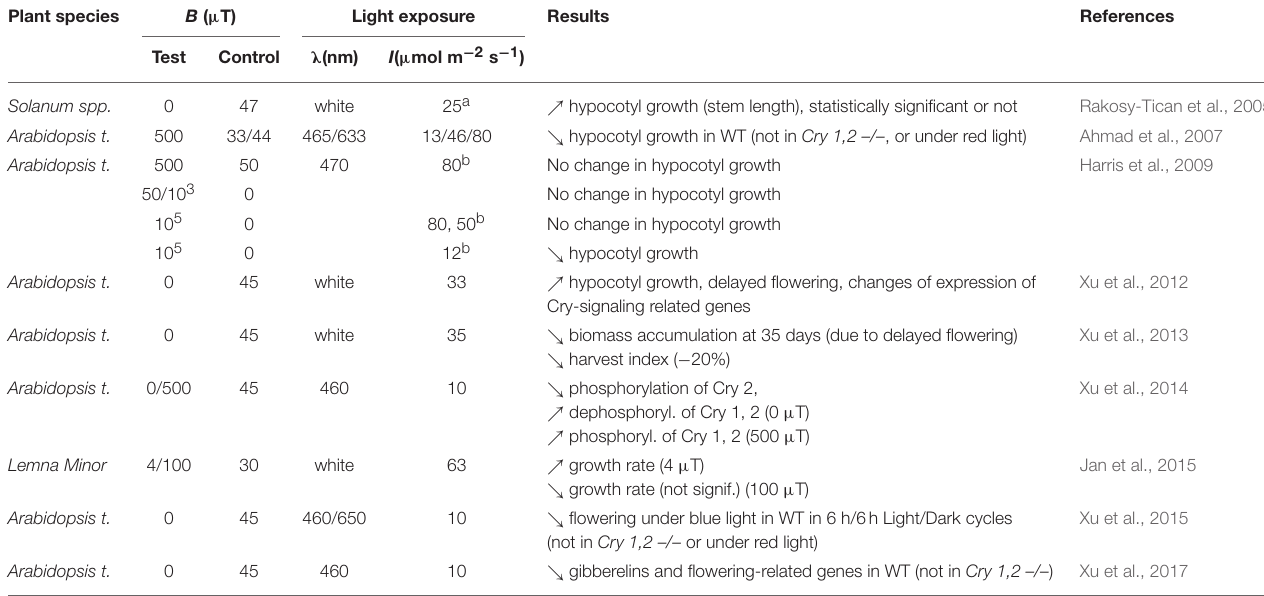
TABLE 1 | Effects of static MF or zero MF ( < 2 µ T) reported in plants that can be related to Cry function, and that have been published in peer-reviewed journals written in English since the year 2,000 ( λ = wavelength, WT = wild-type). All studies have been performed at about 21 ◦ C (25 ◦ C in Rakosy-Tican et al., 2005). Plant species B ( µ T) Light exposure Results Test Control λ (nm) I ( µ mol m − 2 s − 1 ) Solanum spp. white Arabidopsis t.